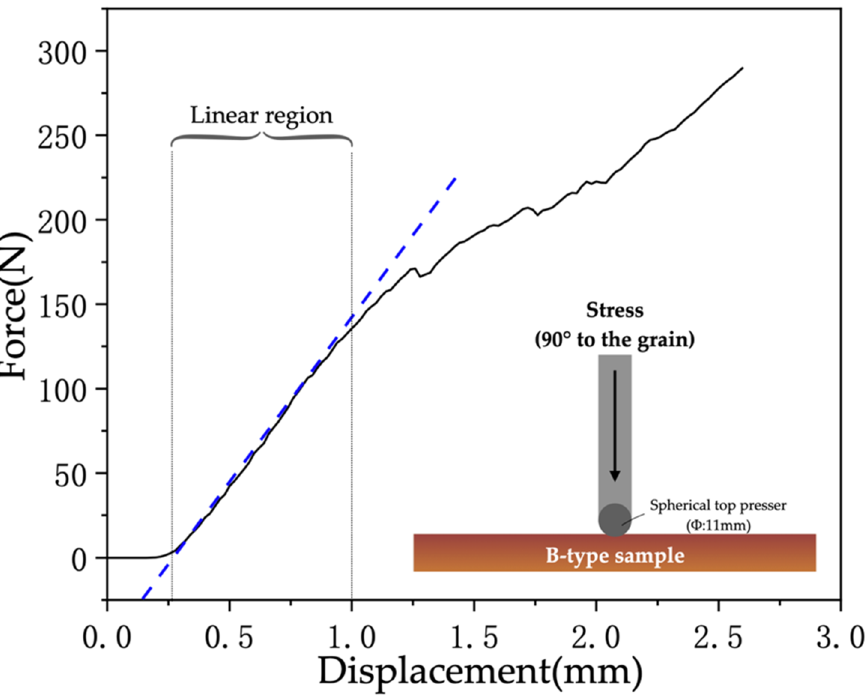
Figure 3. The compression test perpendicular to grain using the concentrated point loading mode and an example of the stress–strain diagram.